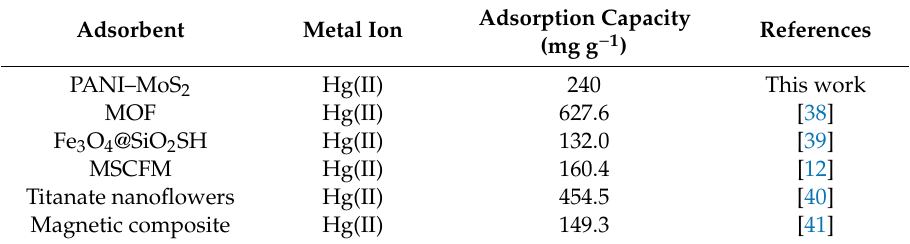
Table 4. Hg(II) adsorption capacities of di ff erent nanomaterials based on previous